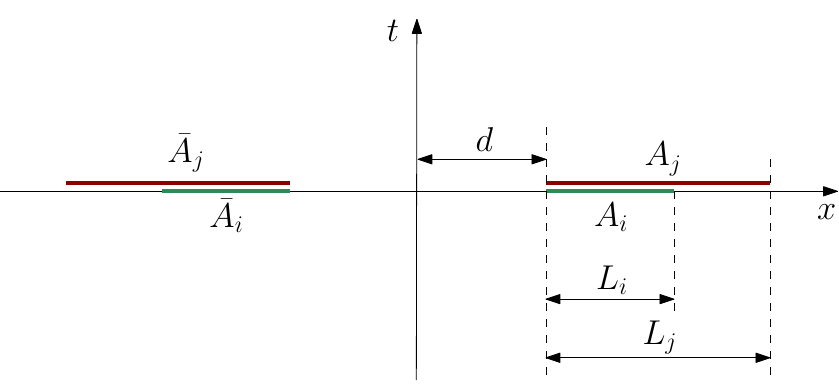
Figure 3 . A i and A j are intervals of respective lengths L i and L j at t = 0 with the same left starting point at x = d . The re(cid:13)ected regions (cid:22) A i and (cid:22) A j are also shown in the